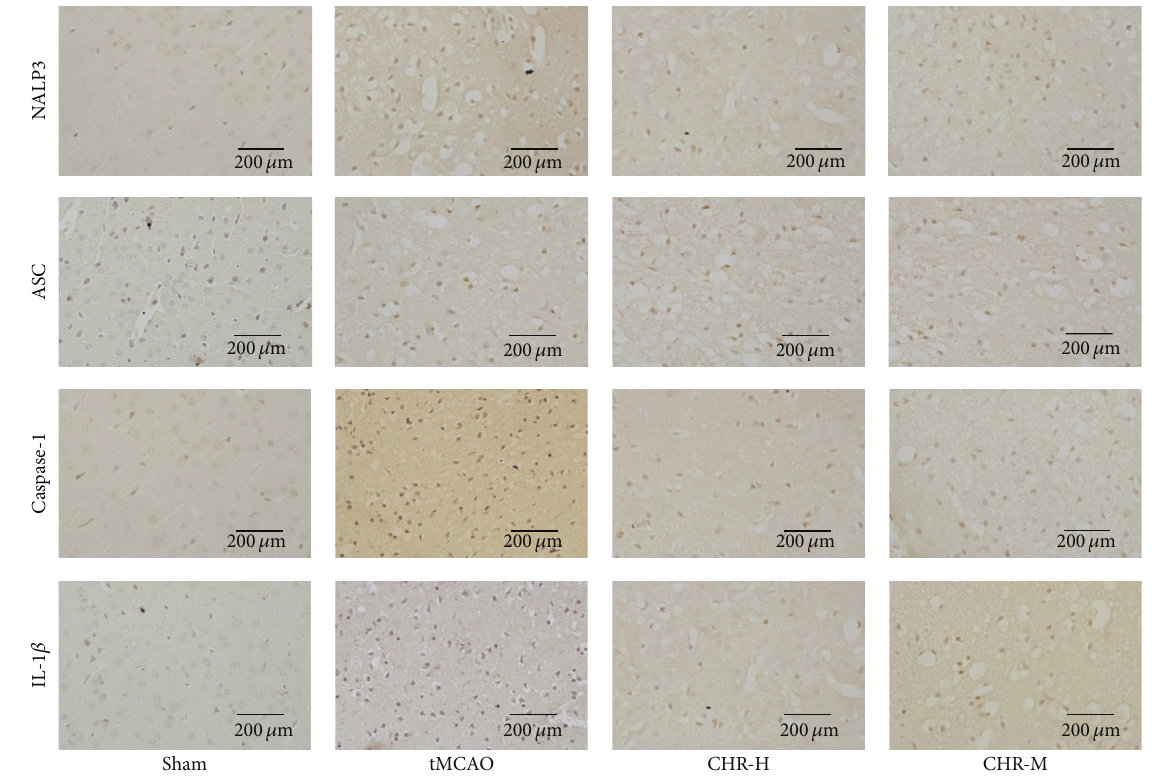
Figure 6: Immunohistochemical staining of NALP3, ASC, caspase-1, and IL-1 𝛽 in the cerebral cortex at 24 h after ischemia (400x magnification). As compared with tMACO and Vehicle groups, the expression of NALP3, caspase-1, and IL-1 𝛽 was significantly reduced in CHR-H and CHR-M groups, but the expression of ASC remained